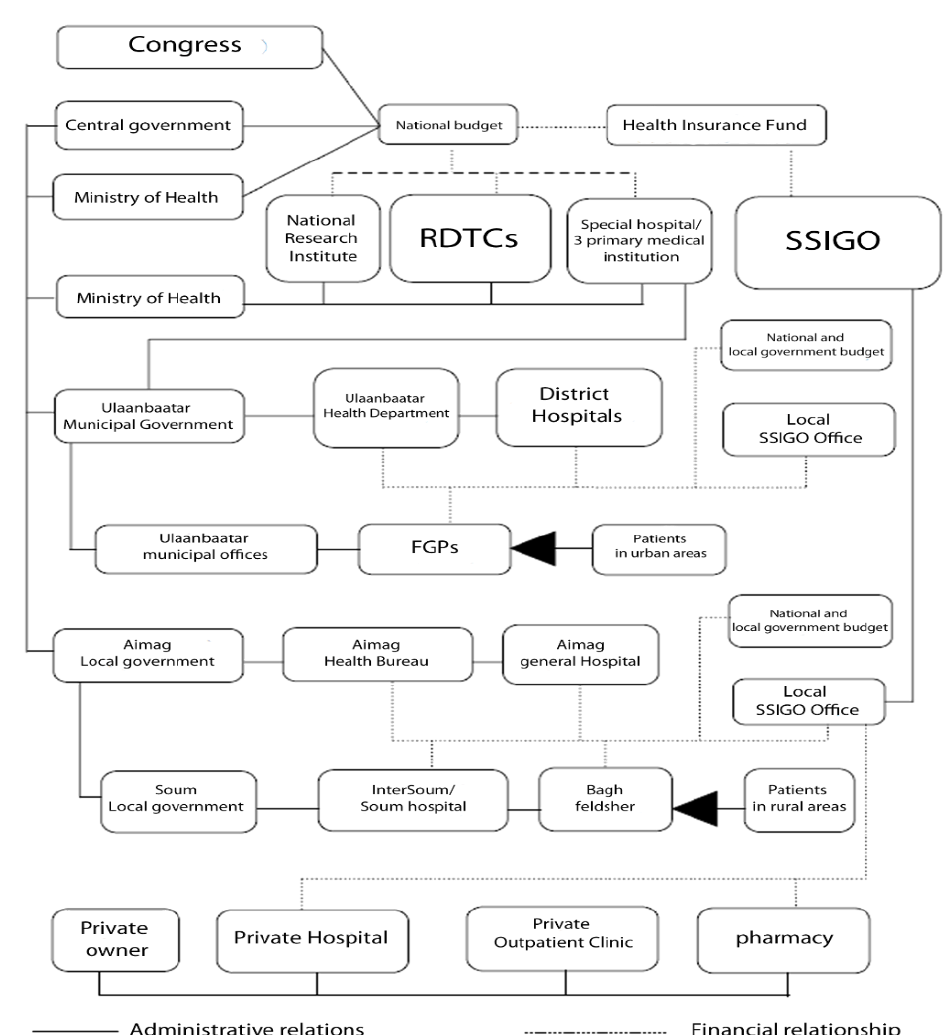
Figure 2. Mongolia’s medical healthcare system.